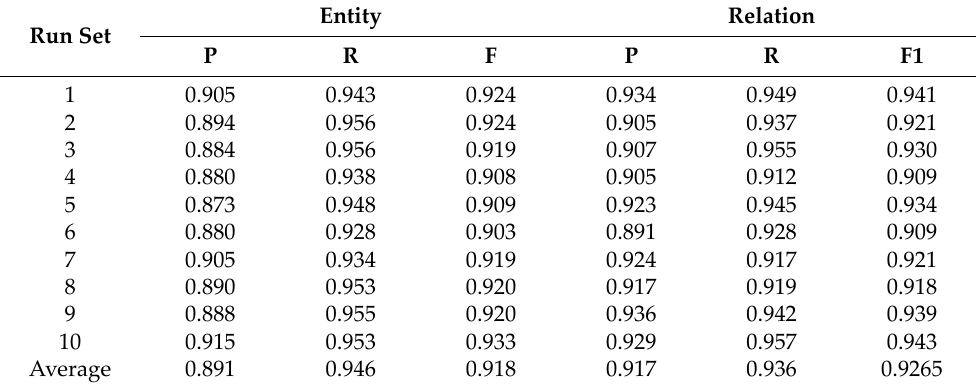
Table 4. Ten‑cross validation.